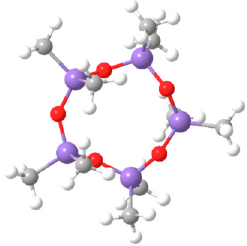
Figure 1. The chemical structure of decamethylcyclopentasiloxane (D5).